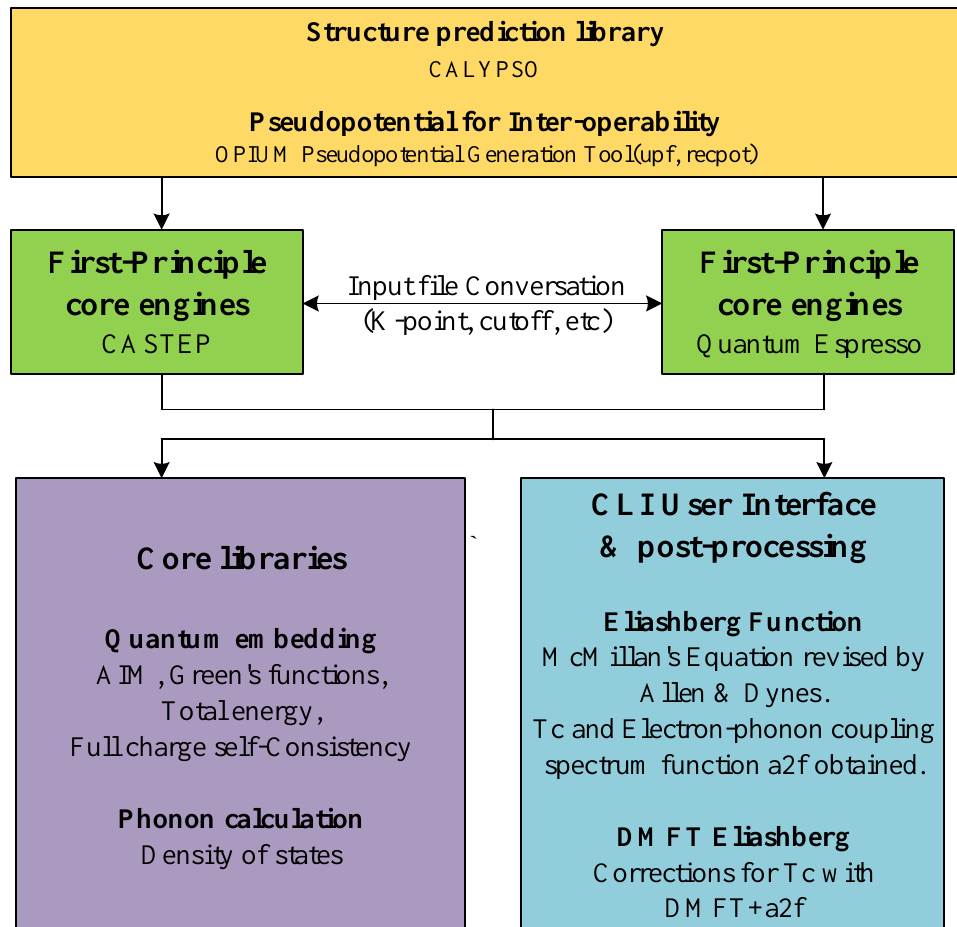
Figure 5. Schematic of the workflow for DFT + DMFT interfaced with Allen–Dynes. Outline of the theoretical platform’s core modules and their interrelationships. To begin with, structures are modeled by crystal structure analysis by particle swarm optimization (CALYPSO), and the pseudopotentials are generated with OPIUM. The main core engines are CASTEP and QE DFT software. We have used format conversion of input files, pseudo-potentials, and K-point grids to ensure interoperability between QE and CASTEP. We employed core libraries to provide many-body corrections using quantum embedding, which also provides updated values for the forces and energies. During the post-processing phase, we used the DMFT + a2F approach to obtain values for the Eliashberg function and superconducting temperature T c . As a final step, data was archived for future usage using HDF5. The Allen–Dynes analysis models the Eliashberg function α 2 F ( ω ) as a sum at the Fermi level over all scattering processes, mediated by phonon momentum transfer [41]: